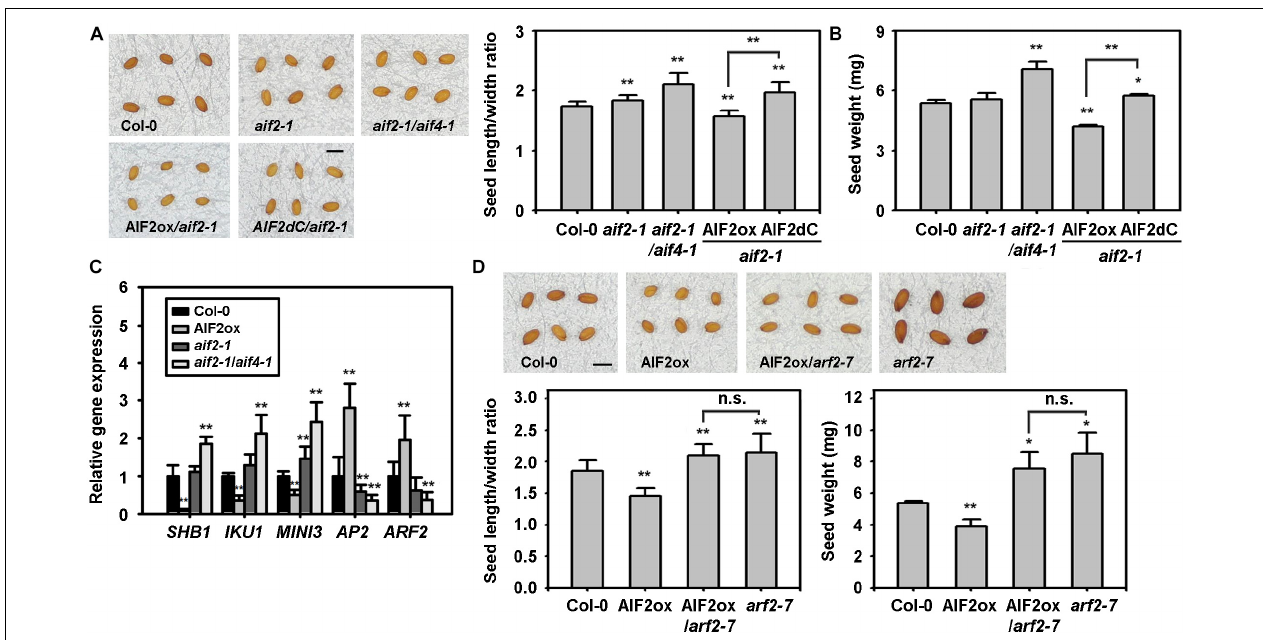
FIGURE 4 | AIF2-mediated negative regulation of seed size and weight. (A,B) AIF2 overexpression-led smaller and rounder (less length to width ratio) (A) and lighter (B) seeds of aif2-1 loss-of-function plants and their reciprocal confirmation through complementation assay with a dominant negative form of AIF2, AIF2dC. (C) Transcript expression of seed size-related genes in siliques with developing seeds. Relative expression of each gene is normalised as a ratio of the Col-0 plants, which was set to 1. (D) ARF2-dependent AIF2 effects on seed size and weight. Scale bars in pictures represent 0.5 mm in length. Statistical difference from the Col-0 control is indicated by an asterisk (*) at P < 0.05 and two asterisks (**) at P < 0.01. n.s., non-significant. Number of seeds examined for measurement of length/width ratio and weight >